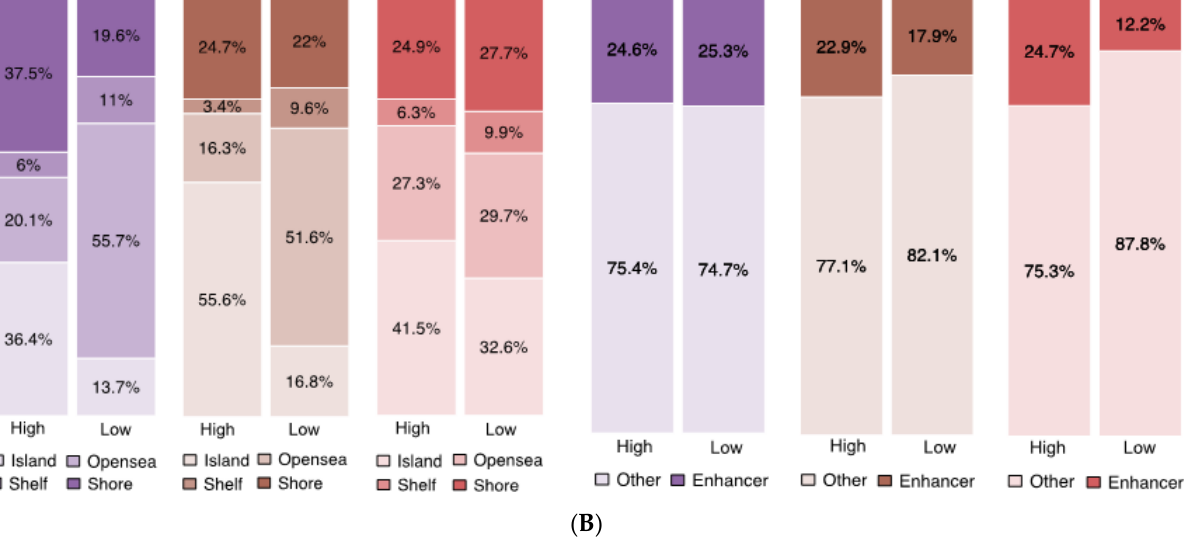
Figure 3. DNA methylation differences in TYAs across medulloblastoma molecular subgroups. ( A ) Intersection of differentially methylated probes (DMPs) in each of the three medulloblastoma (MB) subgroups. DMPs with high methylation levels in TYAs relative to other age groups (left) and DMPs with low methylation levels in TYAs relative to other age groups (right). All probes with a significant FDR adjusted p -value (< 0.05) were compared to determine those shared between different MB subgroups and those unique to a particular subgroup. ( B ) Distribution of DMPs with high methylation levels in TYAs relative to other age groups (“High”), and with low methylation levels in TYAs (“Low”) in the three MB subgroups. Distribution of probes characterised as belonging to island, shore, shelf, and open-sea regions in the genome (left). Percentages of probes mapped to enhancer regions or elsewhere in the genome (right).